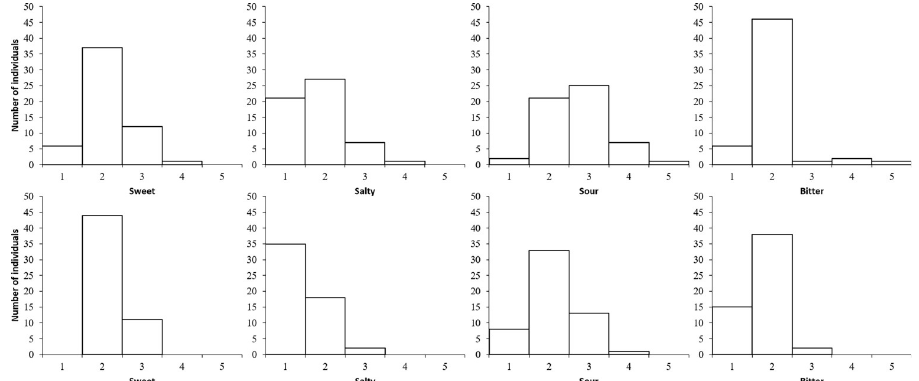
Fig 2. Distribution of taste threshold (upper column: Older adults; lower column: Young adults). The horizontal axis indicates the density of the concentration (1: Lowest, 5: Highest). Thus, a lower concentration level indicates higher taste sensitivity and vice versa.